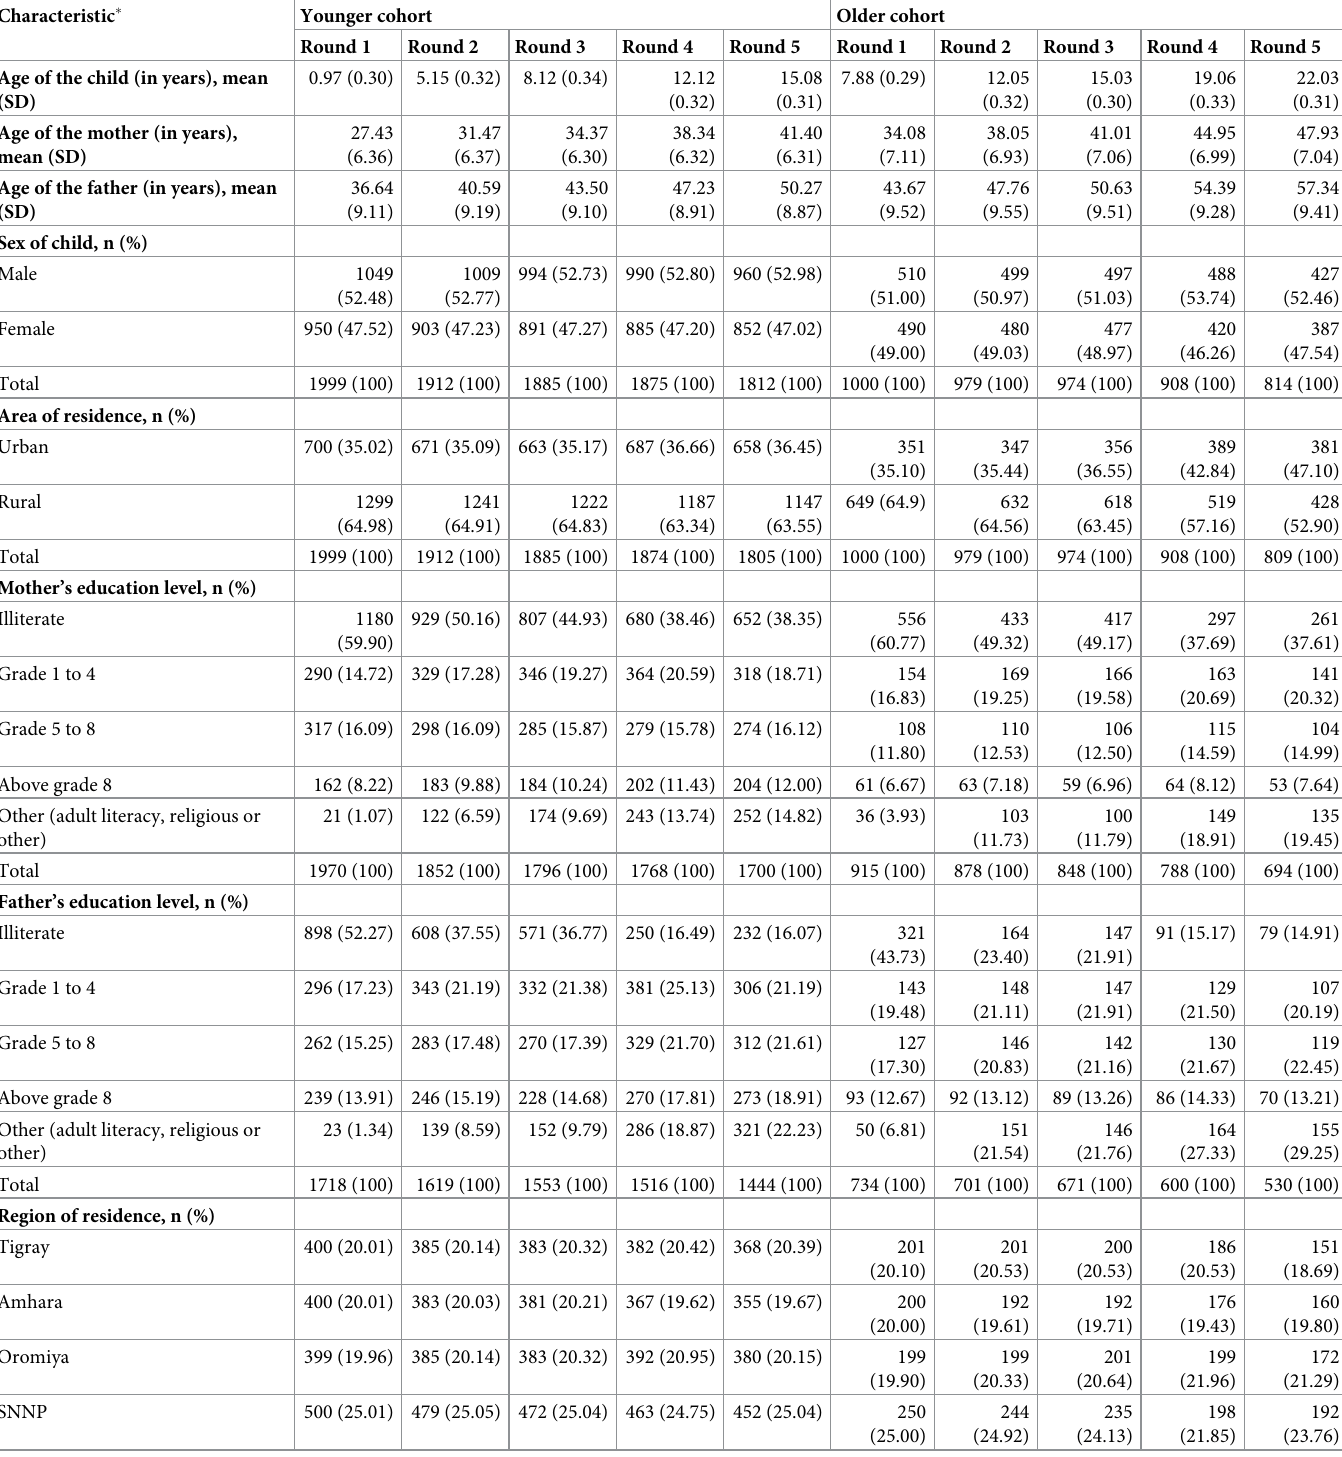
Table 1. Background characteristics of the study participants, Ethiopia,